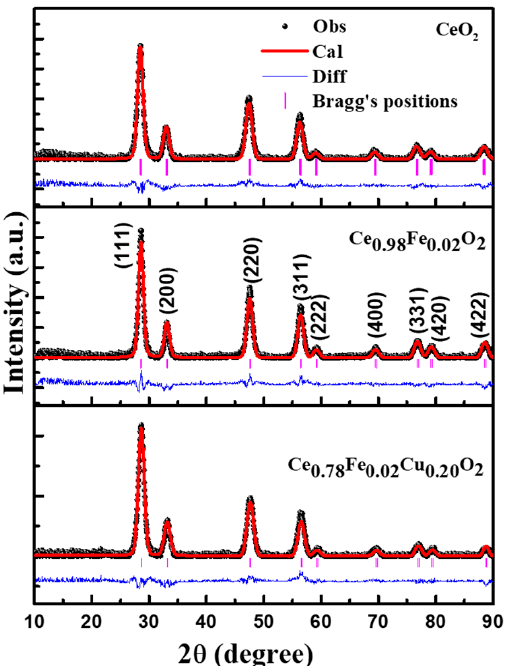
Figure 1. Rietveld refinement of pure CeO 2 , Ce 0.98 F 0.02 O 2 , and Ce 0.78 Fe 0.02 Cu 0.20 O 2 nanoparticles.